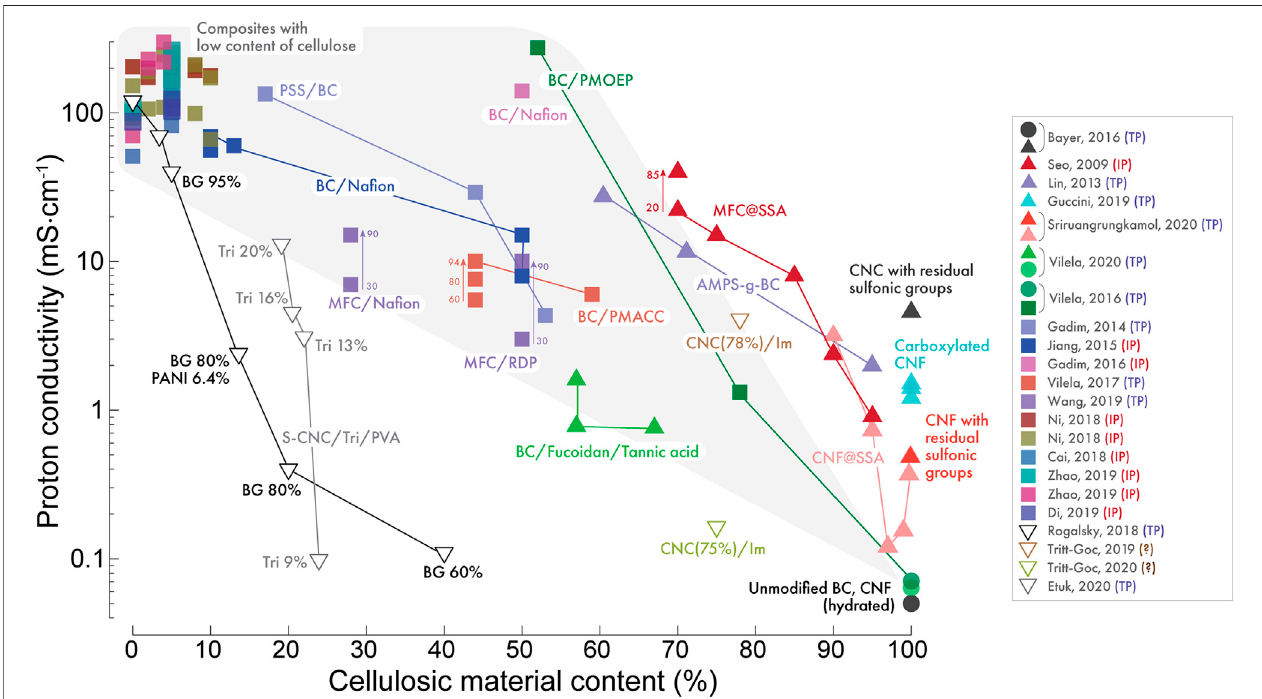
FIGURE 15 | Summary of the proton conductivity of different cellulose containing PEMs reported in the literature, showing the best reported conductivity as a function of the cellulose content in the membrane. Circular data points represent pure cellulose; square points polymer blends; triangular data points functionalized cellulose; and inverted triangles for mixtures with small molecules. Hollow data points were measured in anhydrous conditions. Arrows with numbers indicate the conductivity of same membrane measured at different temperatures ( ° C). Initials following the references indicate if measurements were taken in plane (IP), through-plane (TP), or unreported